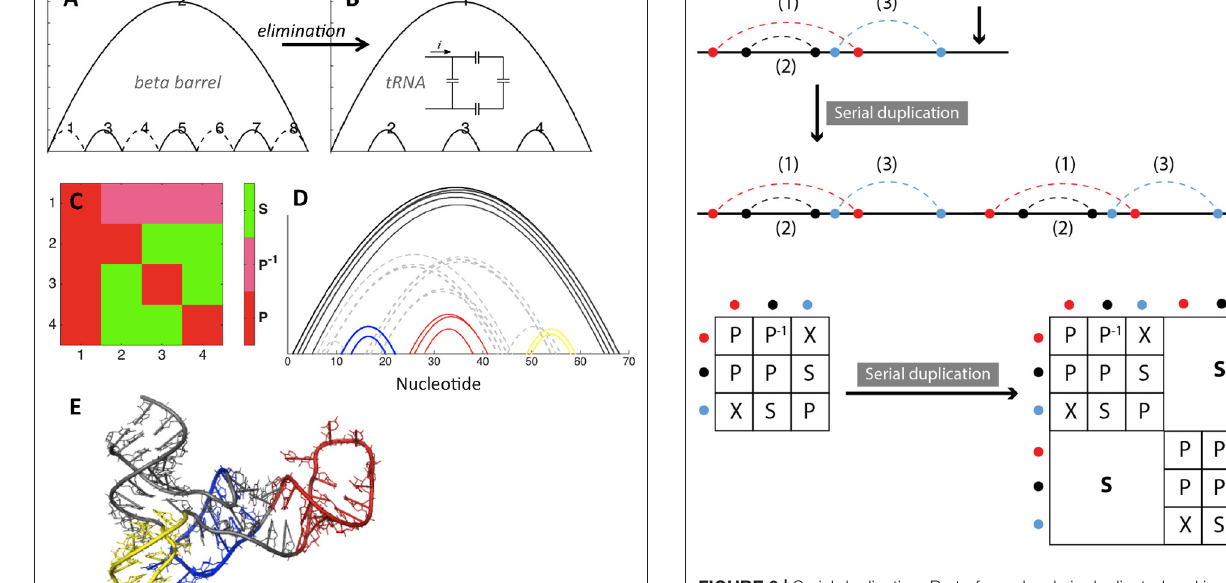
FIGURE 6 | Serial duplication: Part of a molecule is duplicated and inserted outside the original, at position h . Symmetry relations between duplicated and original contacts are